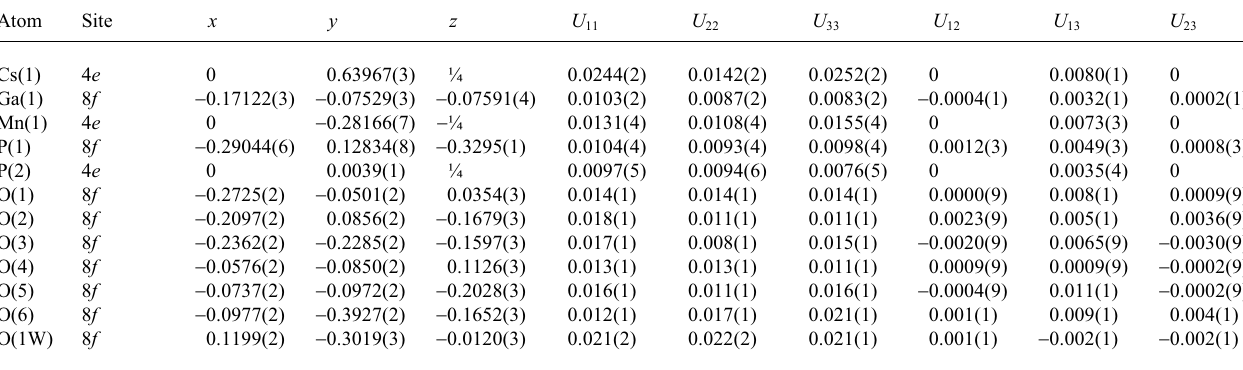
Table 3. Atomic coordinates and displacement parameters (in Å 2 ).